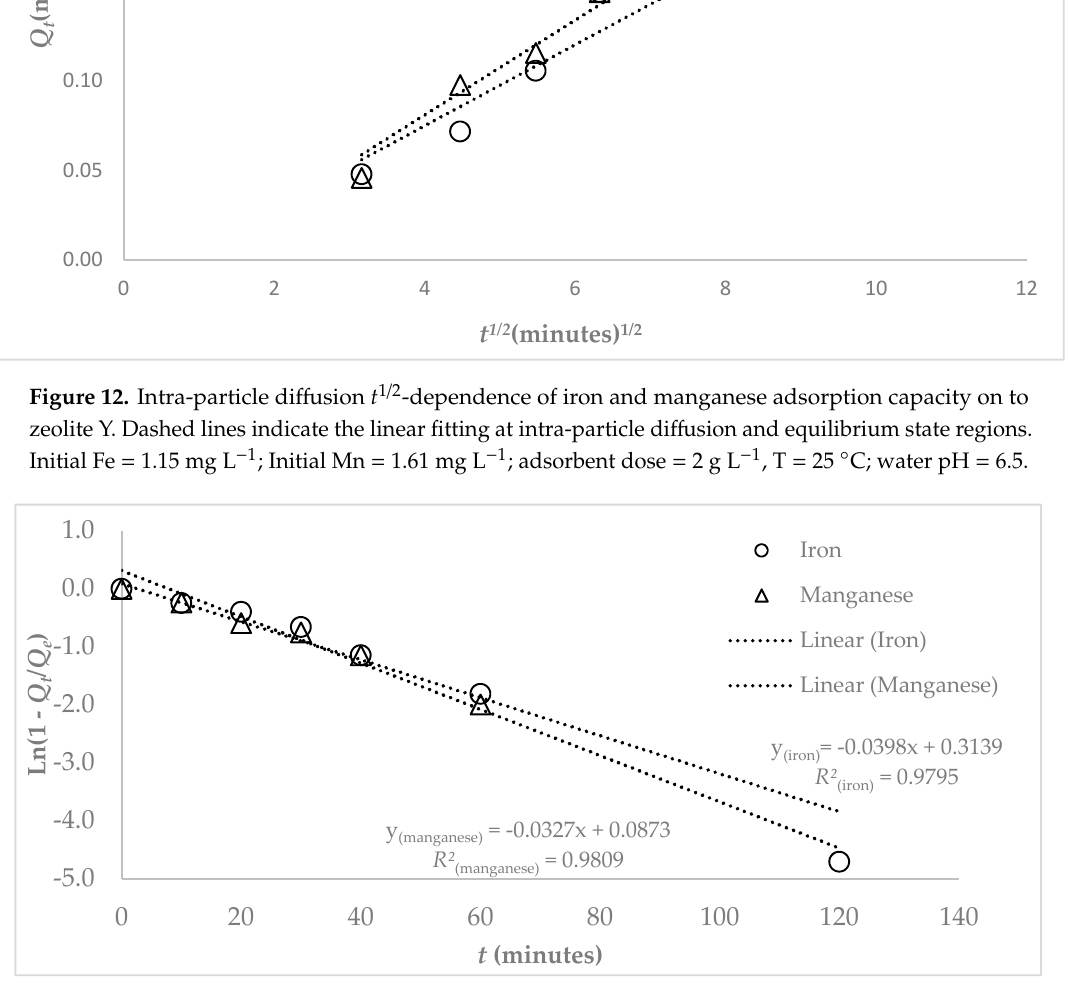
Figure 13. Linearized graph obtained for liquid film diffusion model for iron and manganese uptake ono zeolite Y.